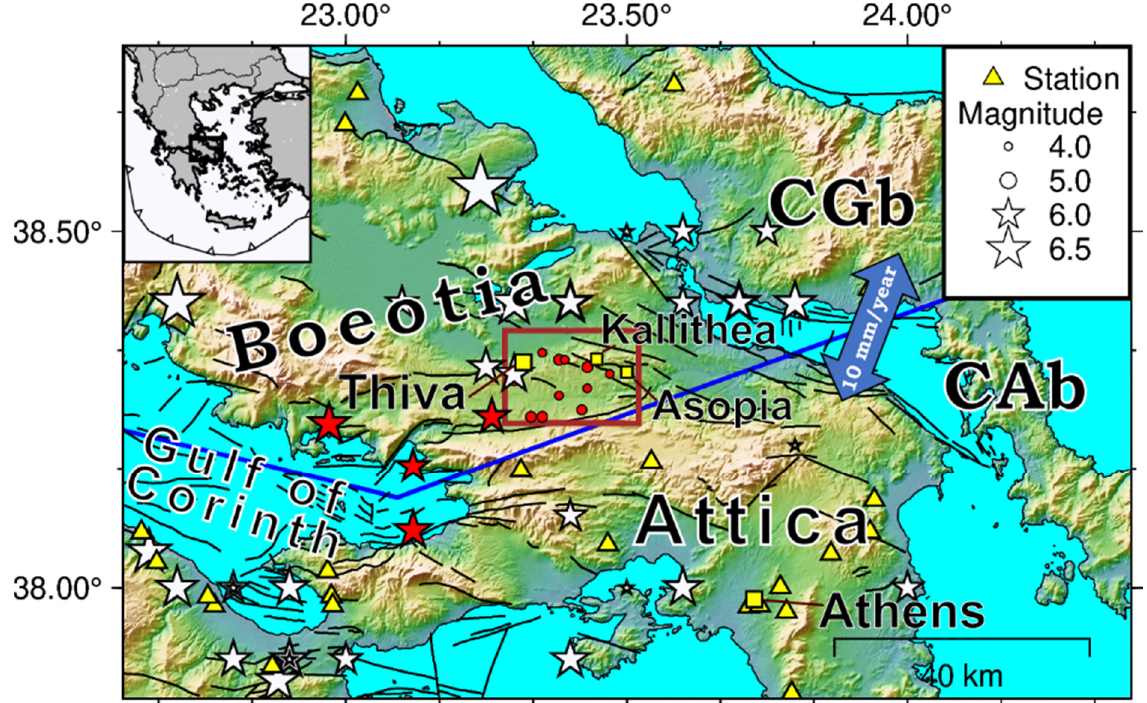
Figure 1. Map of the broader Central Greece area. Epicenters for earthquakes with M ≥ 6.0 (stars) are shown for the whole area, for the historical (white) and instrumental (red) eras. Weaker events, recorded since 1900, are presented (circles) for the study area (brown rectangle). Seismological stations of HUSN (triangles) are also shown. The blue line indicates the boundary between the Central Greece (CGb) and Central Aegean (Cab) blocks proposed by [7]. Faults (black lines) from the NOAFaults v3.0 database [8,9]. Further details about the faults of the study area in Figure 5. Historical earthquakes from [4]. Instrumental seismicity between 1900–2009 according to [1]. Seismicity between 2010 and 2019 was obtained from the reviewed bulletin of the International Seismological Centre. The cities of Athens and Thiva are also shown, as well as the Asopia and Kallithea villages (squares). Inset: location of the map region (black rectangle) in Greece. The trace of the subduction zone is also shown (thin black front). Double arrow indicates the relative movement of the two blocks’ barycenter.